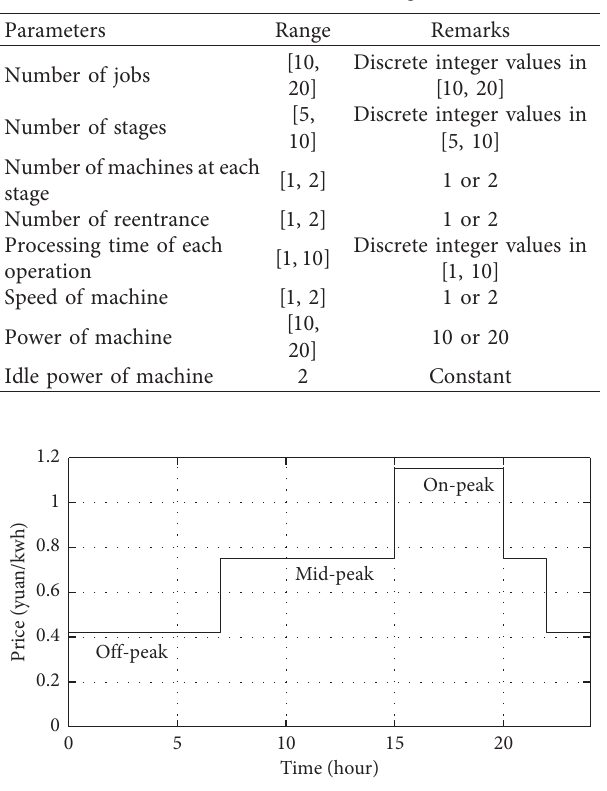
Figure 10: Electricity price over 24-hour time